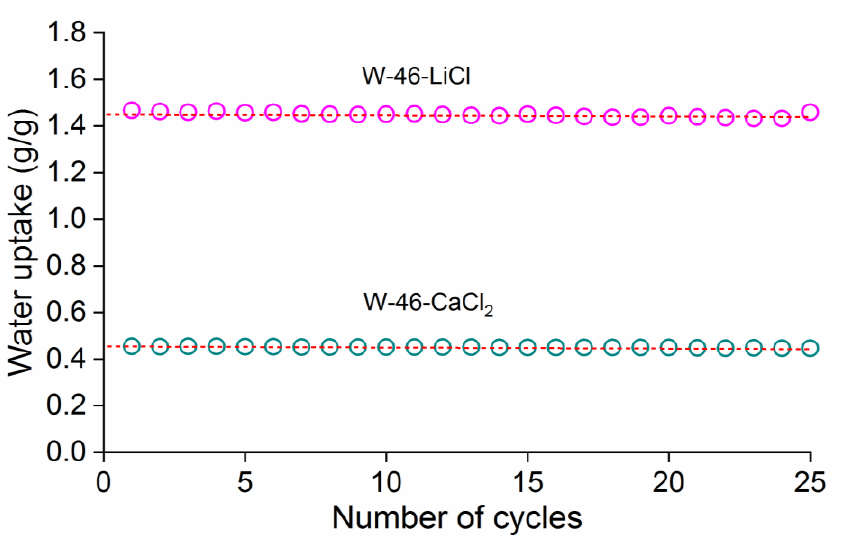
Figure 8. Cycling stability of 25 cycles of sorption and desorption for W-46-CaCl 2 and W-46-LiCl between 35 °C and 100 °C at 12.5 mbar.